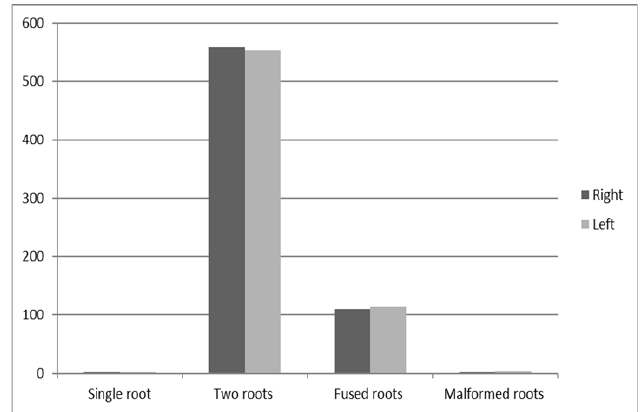
Fig. 2. No. of roots of mandibular third molar with respect to right and left side.